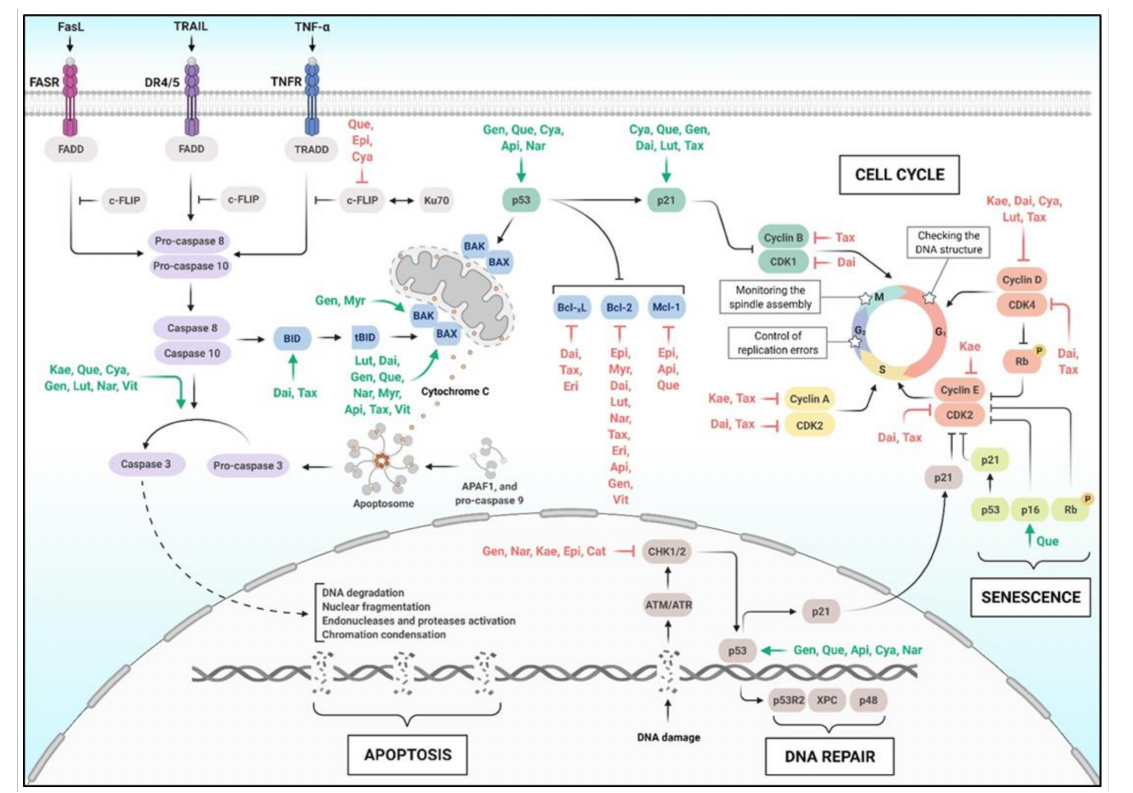
Figure 6. Flavonoids modulate apoptosis, cell cycle, DNA repair, and senescence pathways in cancer. Flavonoids can promote both down-regulation of anti-apoptotic proteins such as Bcl-2, Mcl-1, and Bcl-xL or upregulation of pro-apoptotic proteins as BAK, BAX, and BID. Besides that, flavonoids can also induce the conversion of pro-caspase 3 to activated Caspase 3. All these modulations lead to cancer cell death. Flavonoids also regulate proteins involved with the cell cycle, as p21, CDK1, CDK2, CKD4, and cyclins: D1, A, B, and E, culminating in cell cycle arrest. Proteins involved with DNA damage response as CHK1/2 also are modulated by flavonoids, inhibiting the ability of cancer cells to repair their DNA directing them to apoptosis. Quercetin can also regulate p16, a senescence marker. Epi: Epigallocatechin; Cat: Catechin; Kae: Kaempferol; Myr: Myricetin; Que: Quercetin; Api: Apigenin; Gen: Genistein; Dai: Daidzein; Cya: Cyanidin; Vit: Vitexin; Lut: Luteolin; Nar: Naringenin; Tax: Taxifolin; Eri: Eriodictyol. Original figure made for this review using the Biorender